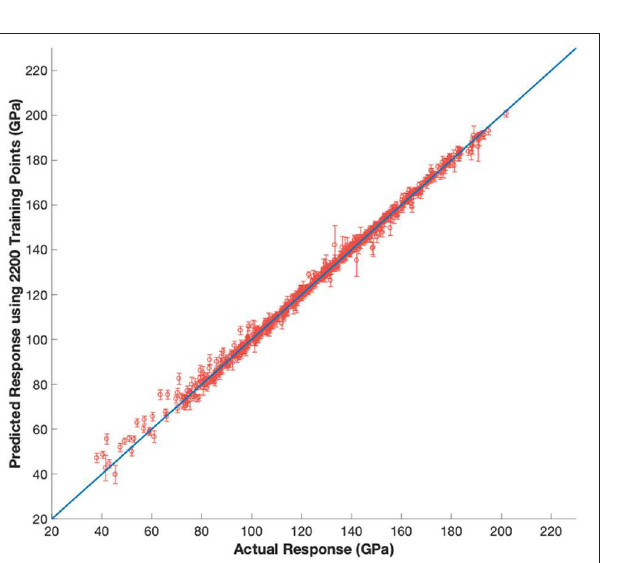
FIGURE 8 | Predictions for the validation set of 600 FE simulations generated from sequential design process using reduced order model with truncations Q = 2, L =